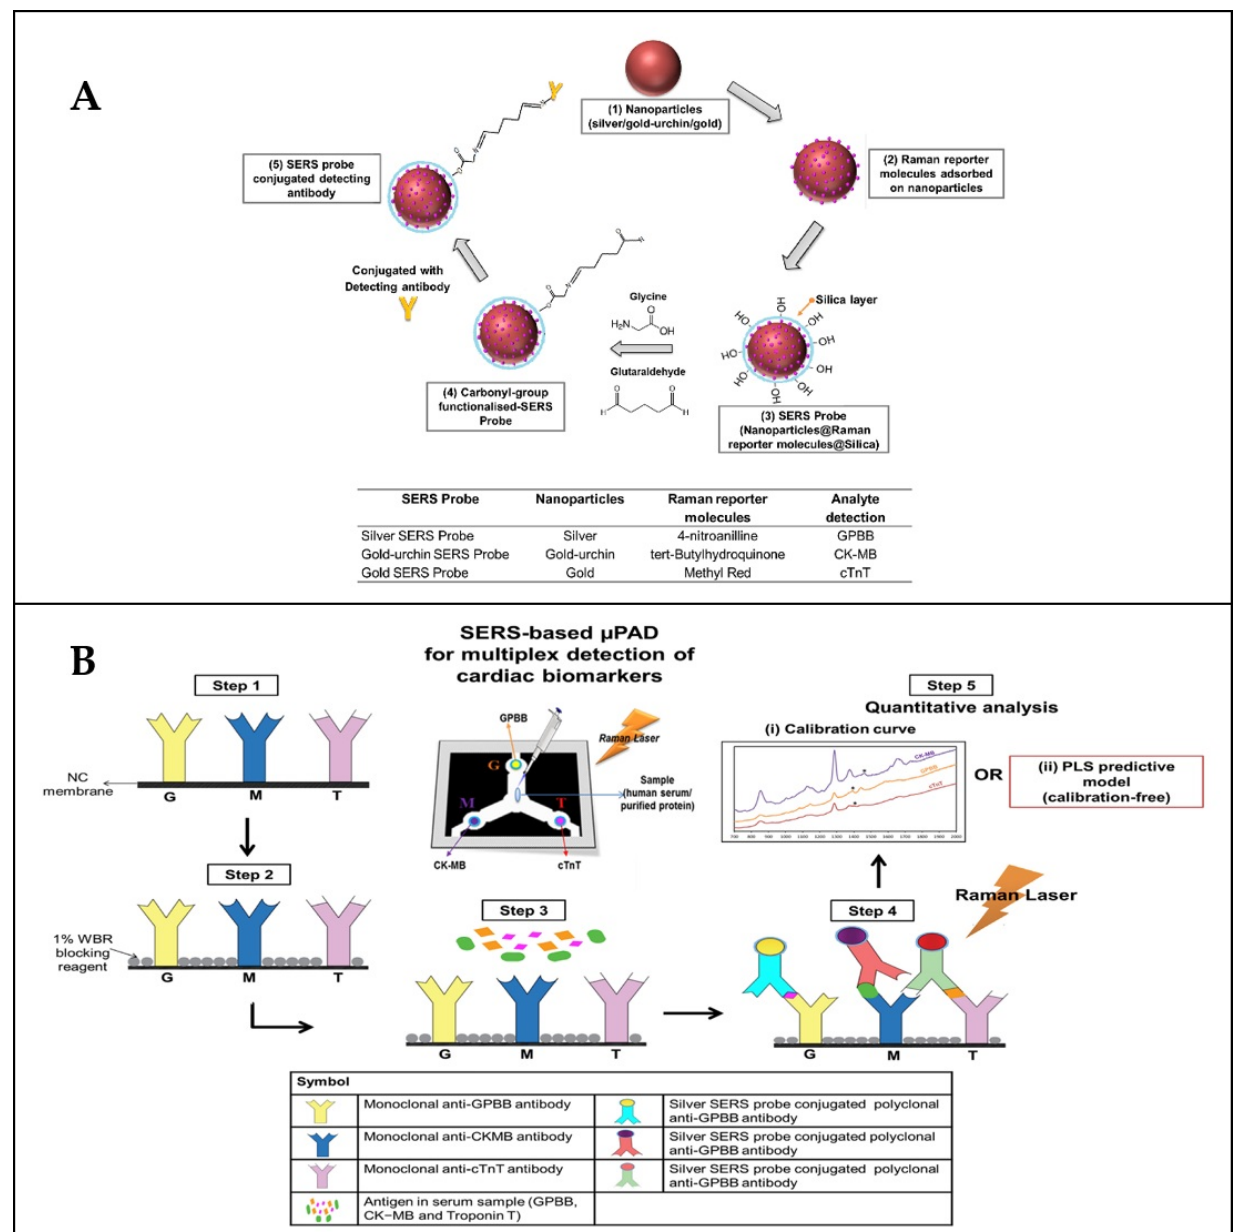
Figure 18. ( A ) Preparation of SERS probe conjugated with detecting antibodies for targeting a spe- cific cardiac biomarker. ( B ) Schematic illustration of multiplex SERS detection of cardiac biomarkers at respective reaction zone(s), G for GPBB, M for CK − MB, and T for cTnT on µPAD. Reproduced with permission from [114]. Copyright 2019 Elsevier B.V.